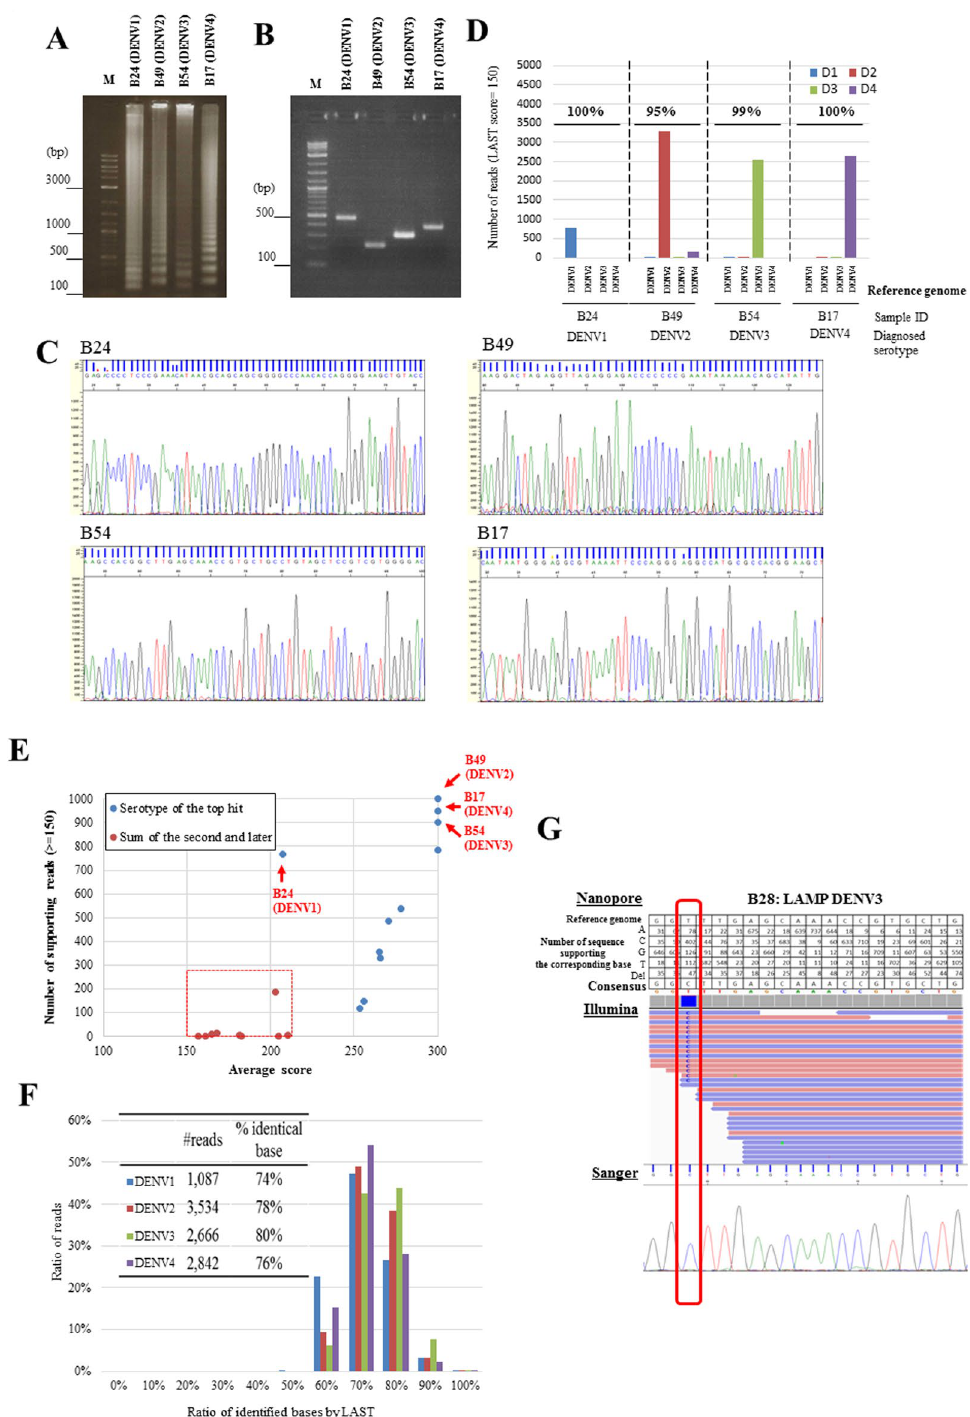
Figure 2. Serotype detection of clinical samples. ( A – C ) Results of the LAMP analysis ( A ), RT-PCR analysis ( B ) and Sanger sequencing ( C ) using clinical samples (n = 4). ( D ) Results of the MinION sequencing; the numbers of sequence reads corresponding to the indicated serotypes are shown. ( E ) Result of alignment for each sample, plotted according to the number ( y -axis) and the average LAST scores of the reads that supported the serotypes of the top hits (blue dots) and the later hits (red dots) (n = 11). The range of negative signals (red dots) is indicated by the broken red box. Note that its range is clearly separate from the positive signals (blue dots). ( F ) The accuracy of the sequencing as calculated above. ( G ) Upper panel, MinION sequence alignment between the generated consensus sequence from a particular patient and the reference genome. Middle and lower panels, results from Illumina (middle panel) and Sanger sequencing (lower panel) using the same sample. The position of the identified SNV is highlighted by the red box. This image is a representation of one patient